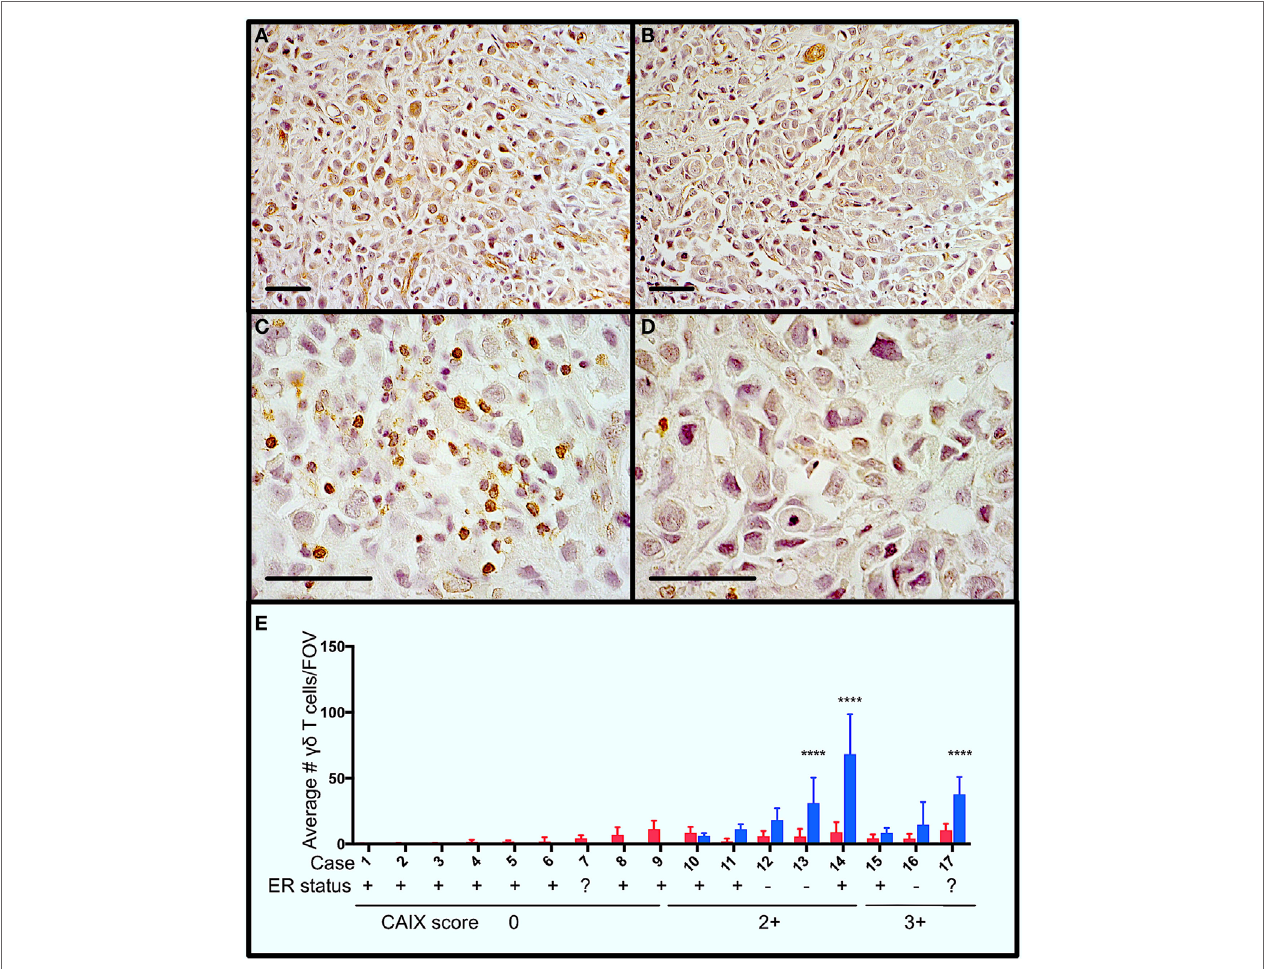
FigUre 1 | Gamma delta T cells ( γδ Tcs) are present in areas of hypoxia in estrogen receptor positive (ER + ) breast tumors. Serial sections from ER + breast tumors were stained for carbonic anhydrase IX (CAIX) and T cell antigen receptor δ . (a) Example of CAIX-positive staining at 400 × magnification from case 14; (B) CAIX-negative field of view (FOV) from the same slide as in (a) ; (c) γδ Tc in the same area as (a) at 1,000 × magnification; and (D) γδ Tc in the same area as (B) at 1,000 × magnification. Scale bars are 50 µm. Brown indicates positive staining. (e) Parallel staining for γδ Tc and CAIX suggests that γδ Tc infiltration increases in hypoxic regions. CAIX scoring is indicated below the case numbers: 0 = no staining; 1 = weak and/or very focal staining; 2 + = strong but focal staining; and 3 = strong and extensive staining. Quantification and statistical analysis of γδ Tc frequency in CAIX-positive versus -negative regions (blue and red bars, respectively) reveal significantly increased γδ Tc infiltration in hypoxic regions (two-way ANOVA, **** P <